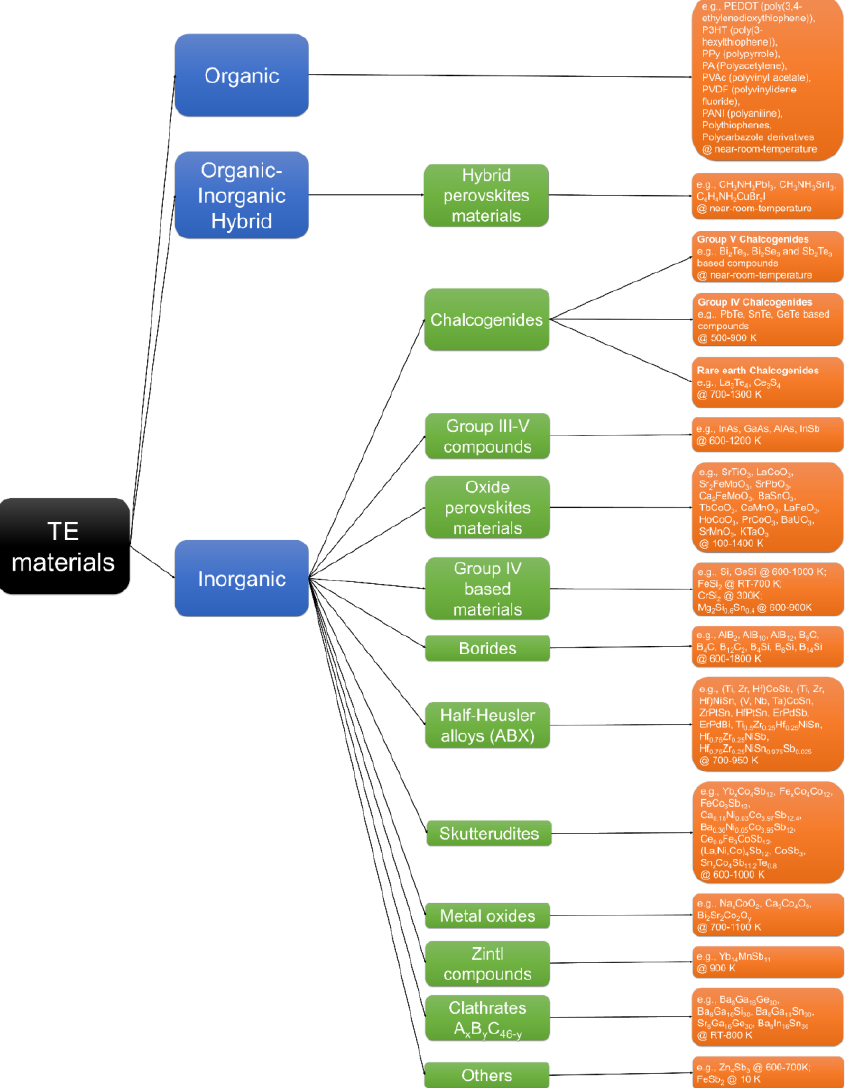
Figure 2. Thermoelectric materials studied through experimentation or calculation.